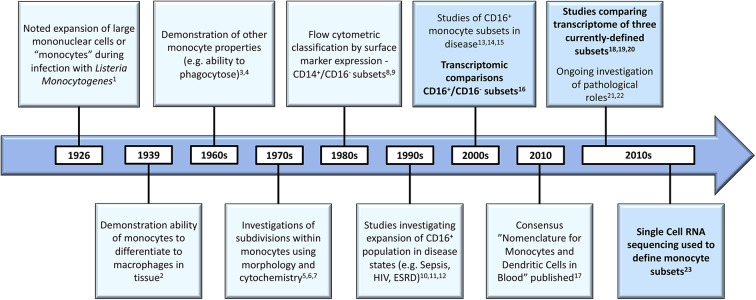
Developments in the understanding of monocyte biology in the past several decades [1. (8), 2. (9); 3. (10); 4. (11); 5. (12); 6. (13); 7. (14); 8. (15); 9. (16); 10. (17); 11. (18); 12. (19); 13. (20); 14. (21); 15. (22); 16. (23); 17. (24); 18. (25); 19. (26); 20. (27); 21. (28); 22. (29); 23. (30)]. Developments in gene expression analysis are bolded and these boxes highlighted. HIV, Human Immunodeficiency Virus; ESRD, End Stage Renal Disease.